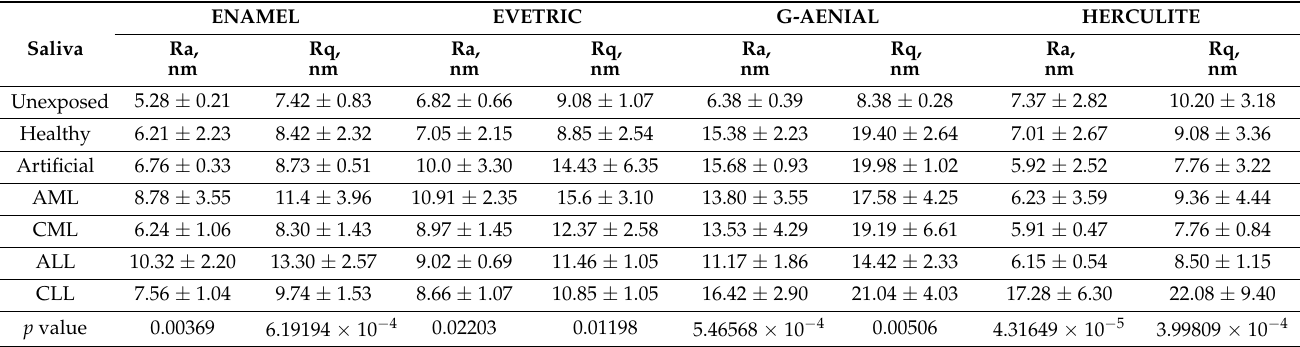
Table 2. Mean values of the surface